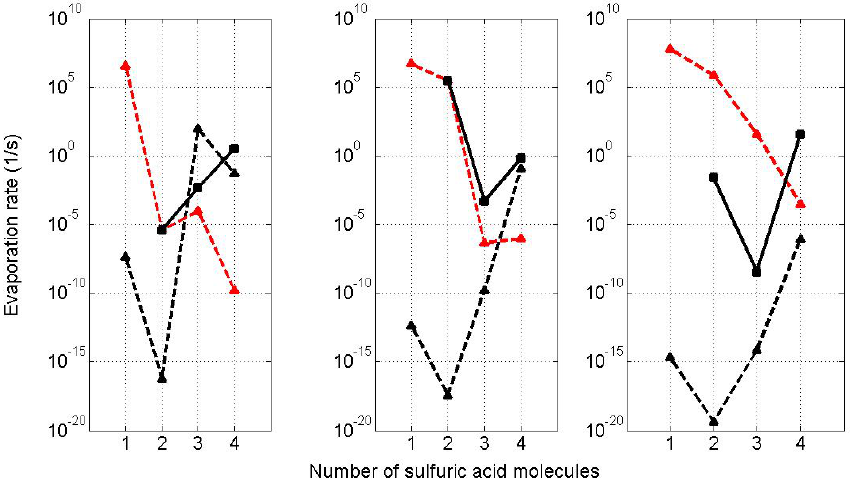
Fig. 3. Evaporation and fission (non-monomer evaporation) rates from DMA / H 2 SO 4 clusters. Left panel: clusters with two DMA molecules. Middle panel: clusters with three DMA molecules. Right panel: clusters with four DMA molecules. Red dashed lines are the evaporation of DMA from the cluster, black dashed lines are the evaporation of sulfuric acid from the cluster, and solid black lines are the cluster fission reactions leading to the formation of the most stable daughter cluster ((H 2 SO 4 ) 2 • (CH 3 ) 2 NH for fission of two DMA clusters and (H 2 SO 4 ) 2 • ((CH 3 ) 2 NH) 2 for fission of three and four DMA clusters).